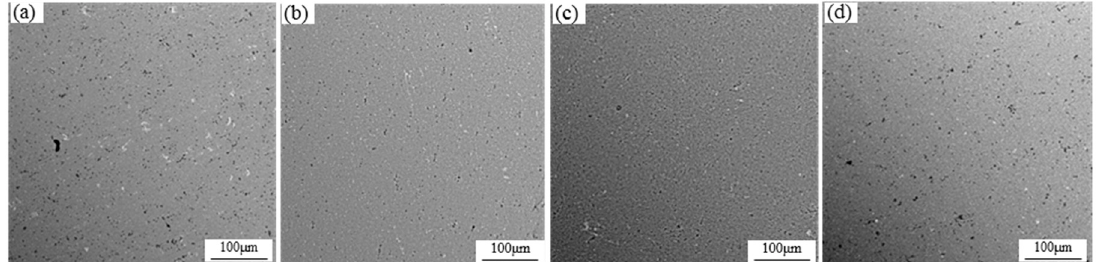
Figure 6. The precipitated phases of the subsequent cold rolling of the 1060 aluminum alloy cast rolling strip: ( a ) the top surface of the strip with added 0.18 wt% Al-Ti-B refiner and applied conventional treatment; ( b ) the top surface of the strip with added 0.18 wt% Al-Ti-B refiner and applied ultrasonic treatment; ( c ) the top surface of the strip with added 0.12 wt% Al-Ti-B refiner and applied ultrasonic treatment; ( d ) the top surface of the strip with added 0.09 wt% Al-Ti-B refiner and applied ultrasonic treatment.